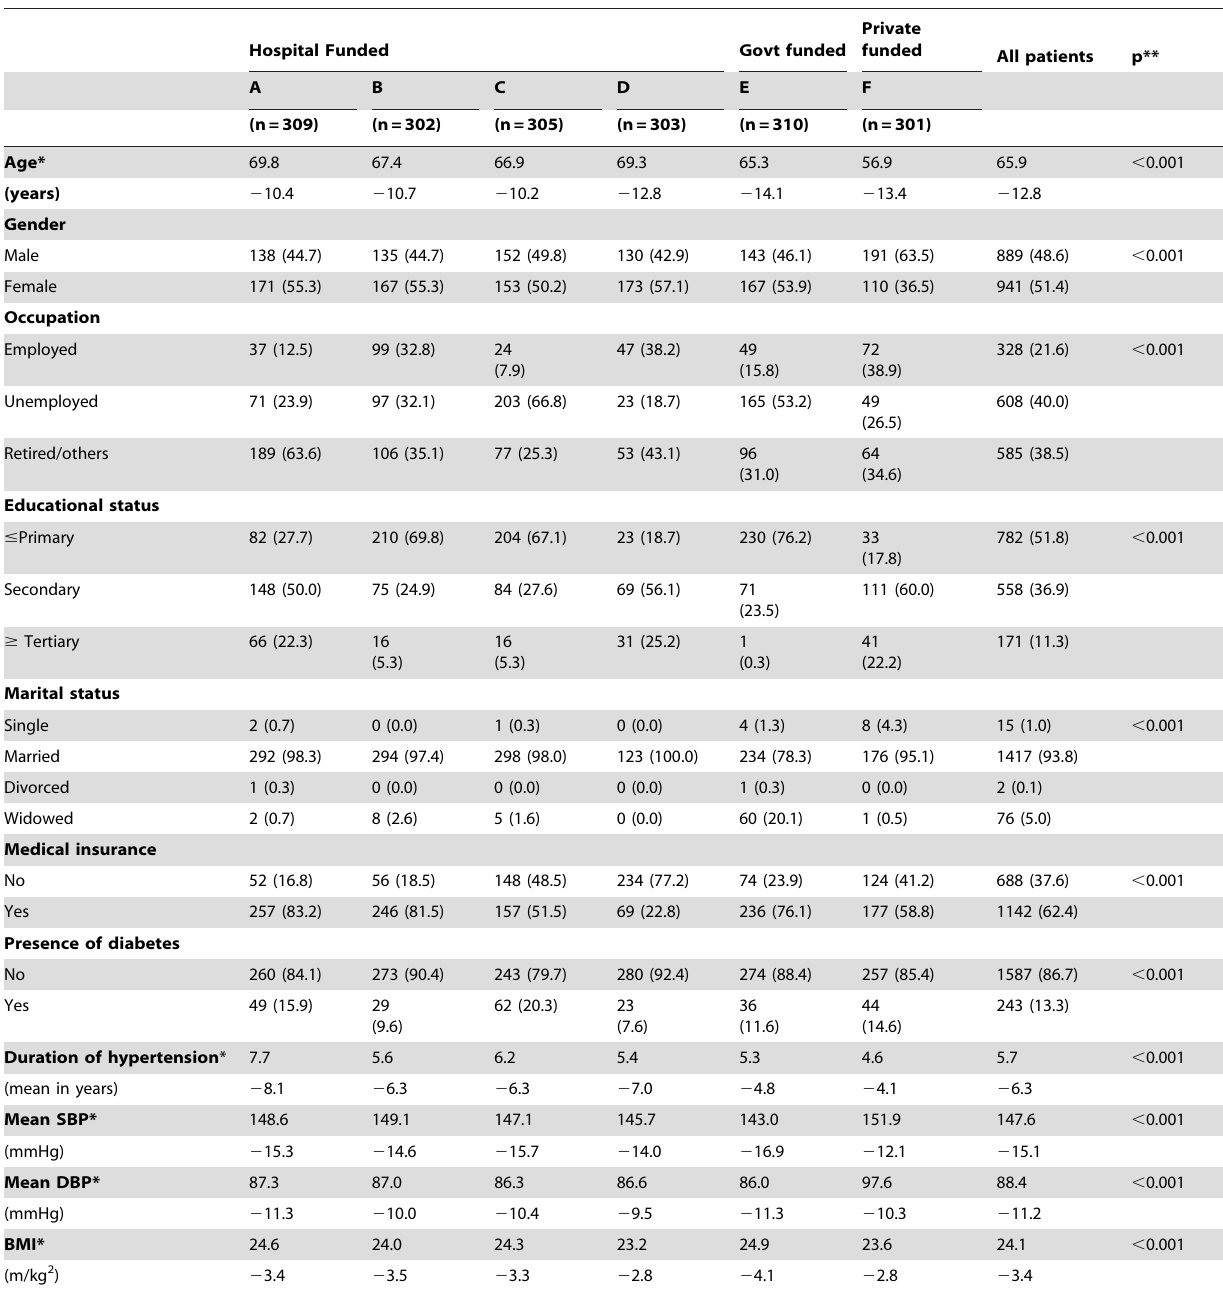
Table 2. Patient Characteristics (N=